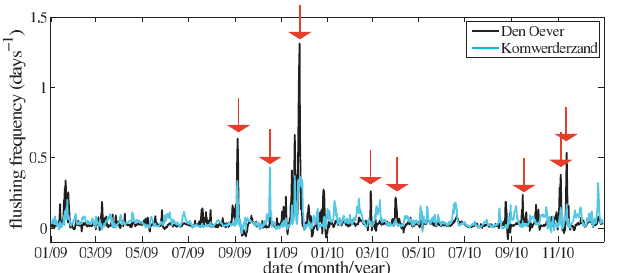
Figure 19. Flushing frequency (days − 1 ) of the fresh water from the sluices of Den Oever and